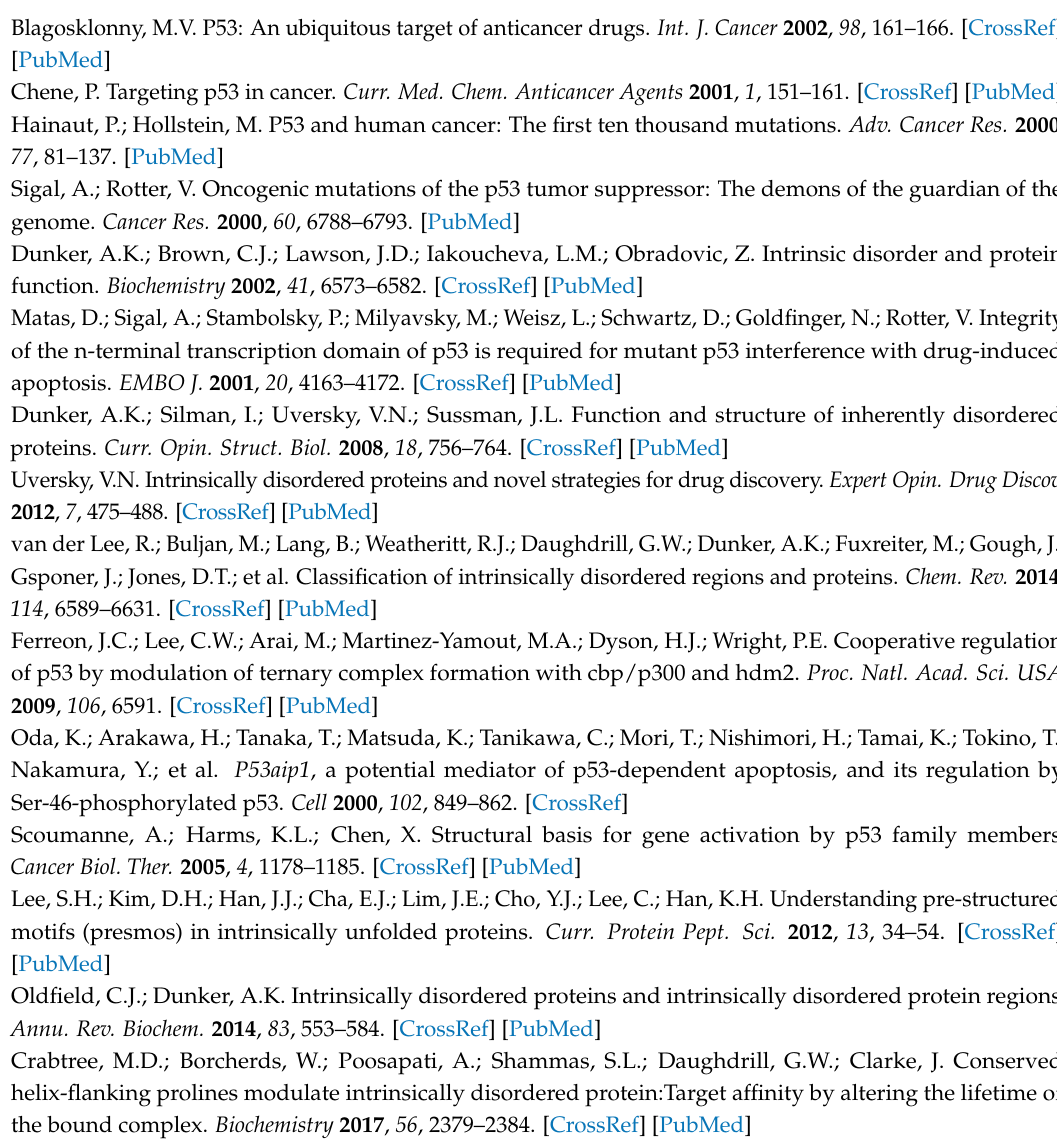
Figure S1: Partial phosphorylation yields no chemical shifts in the primary MDM2 binding